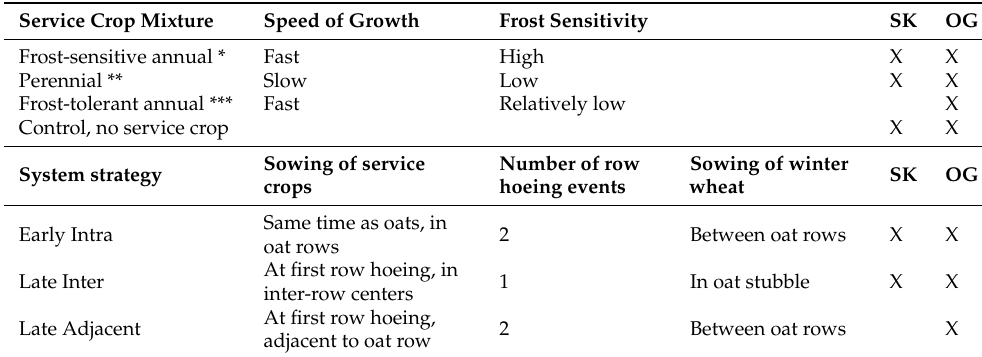
Table 1. Main characteristics of the different levels of the two treatment factors; service crop mixture and system strategy. The two columns to the far right indicate at which experimental regions, SK = Skåne or OG = Östergötland, each factor level is present. For visualization of the sowing of service crops in the different system strategies, see Figure